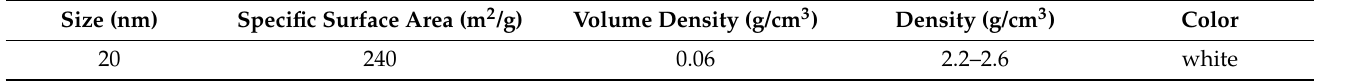
Table 2. The physical properties of Nano-Silica.